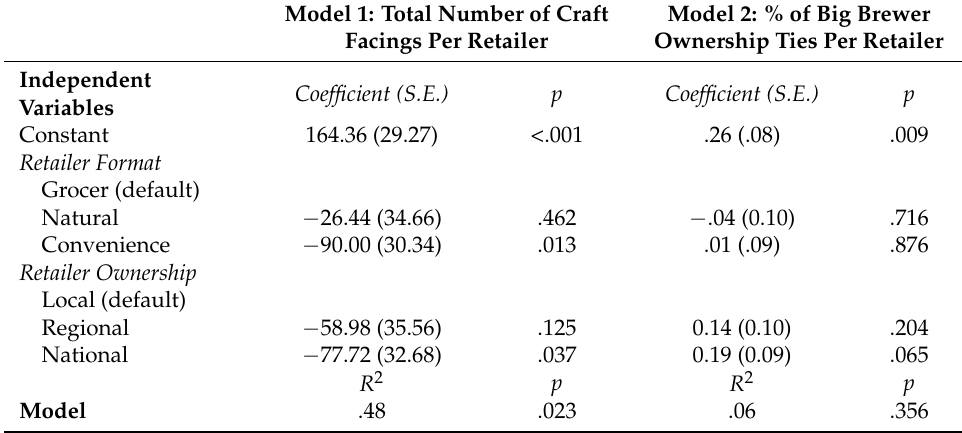
Table 3. Ordinary least squares regression models for retailers: (1) total number of craft facings; and (2) percentage of craft facings owned by big brewers ( n = 16) 1